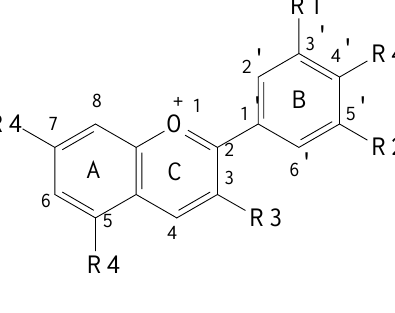
Figure 2. The flavylium cation. R1 and R2 are H, OH, or OCH or H and R4 is OH or a glycosyl [3,